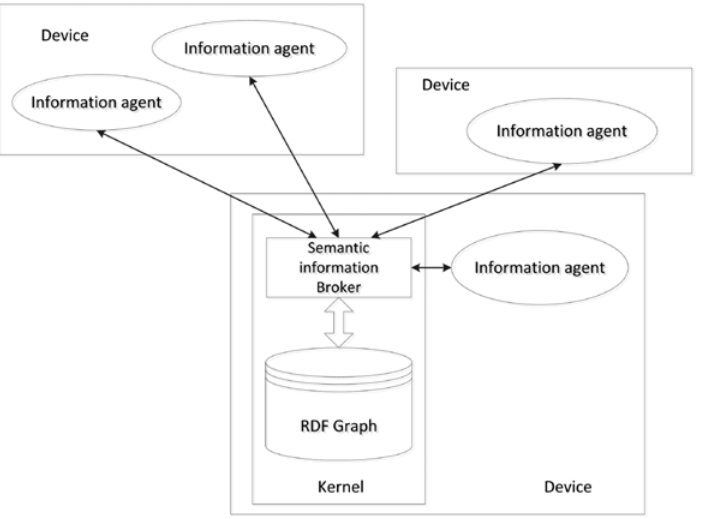
Figure 1: Smart-M3 Reference